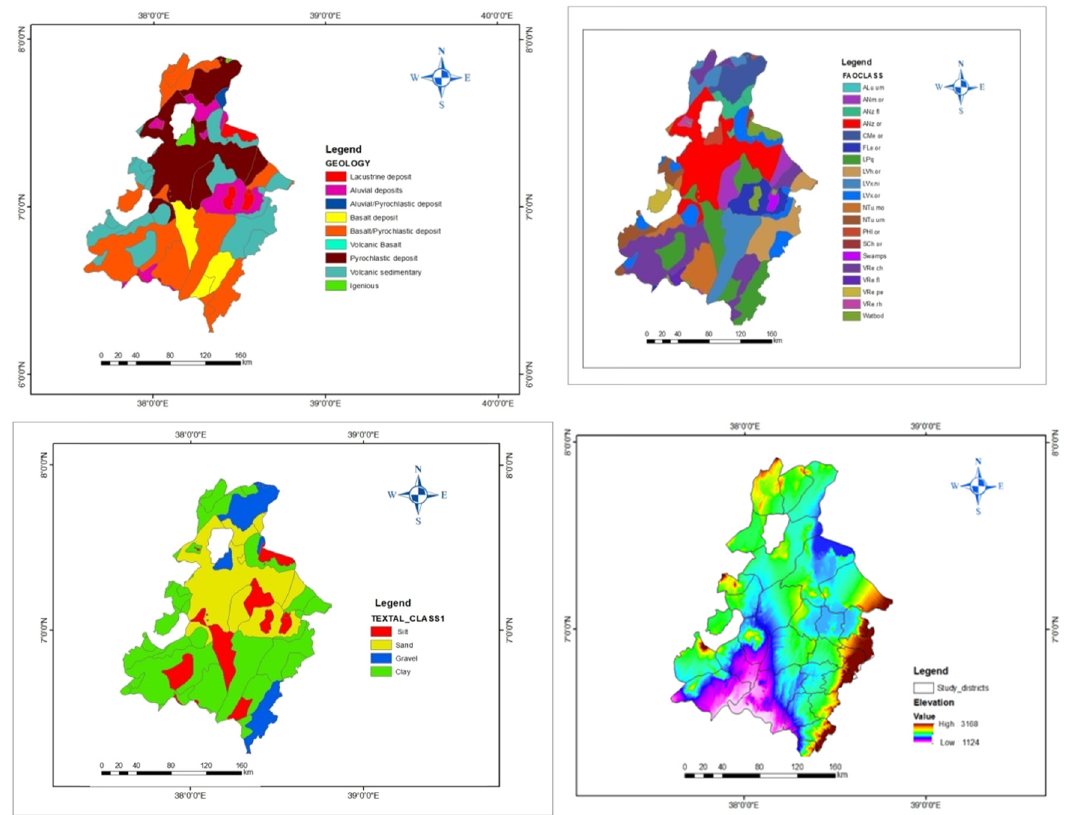
Figure 8: Geology, altitude, and textural class of soils in the four clusters.